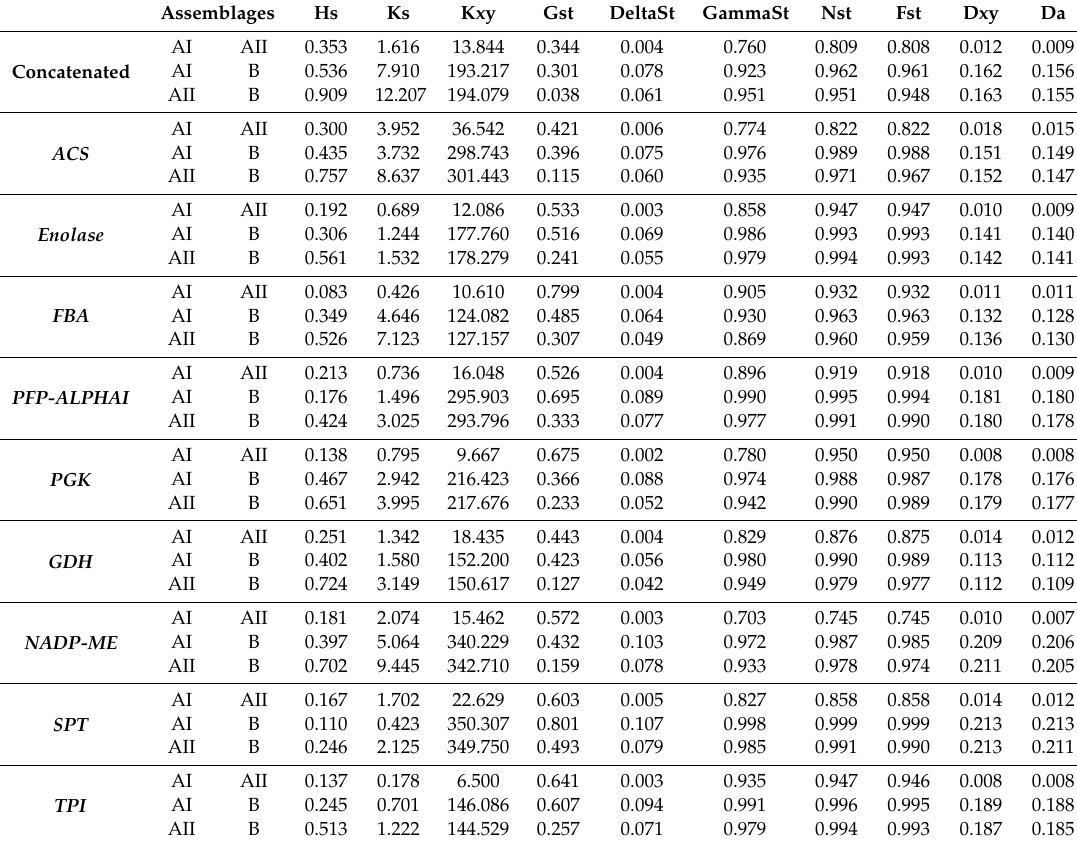
Table 4. Genetic di ff erentiation among populations with concatenated sequences and each